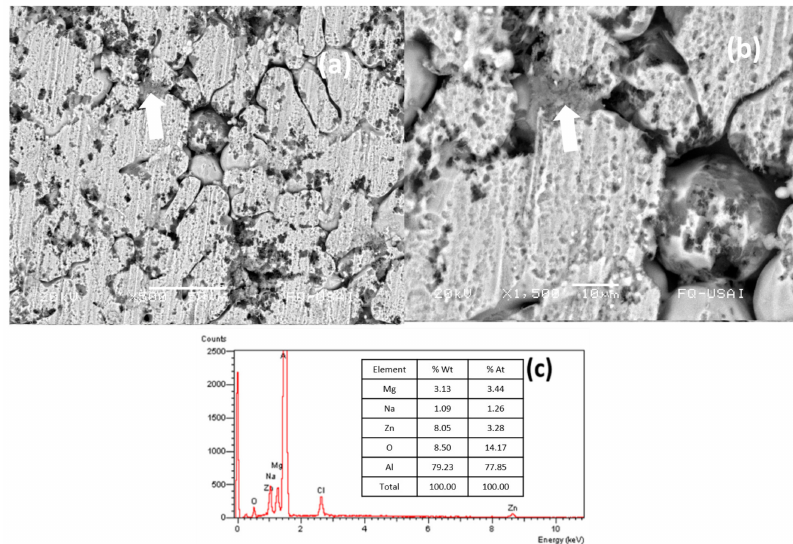
Figure 9. Micrographs and EDS recorded when stopped at a fixed current density ( a) low magnification, ( b ) high magnification, and ( c ) microanalysis of the corrosion products from series 1.